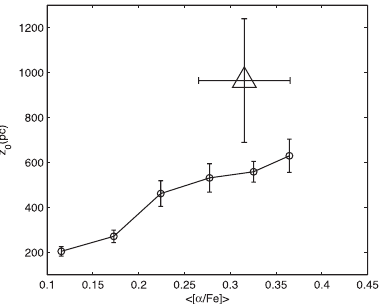
Figure 1. Left panel: Star-count corrected density distribution of G dwarf stars in [Fe/H] metallicity versus [ (cid:1) / Fe] abundance. The blue and green lines show the tracks of metal-rich and metal-poor populations, respectively. Middle and right panel: Median guiding radius R g (in kpc) and median eccentricity of the orbits of the G dwarf stars.